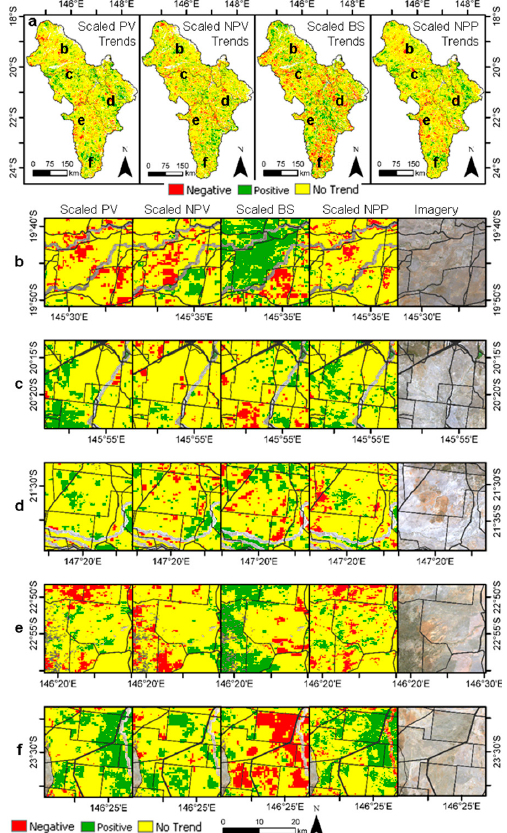
Figure 5. Comparison of inter-annual trends of individual scaled components of fractional cover and scaled NPP from 2000 to 2013 ( a ) for the entire BDT from November to April showing, scaled photosynthetic vegetation (PV), scaled non-photosynthetic vegetation (NPV), scaled bare soil (BS) cover, scaled NPP with fine scale comparisons of the five locations shown in ( a ) and a true color composite of Landsat imagery. Grey lines in ( a ) are basin boundaries and in ( b – f ) are property boundaries.